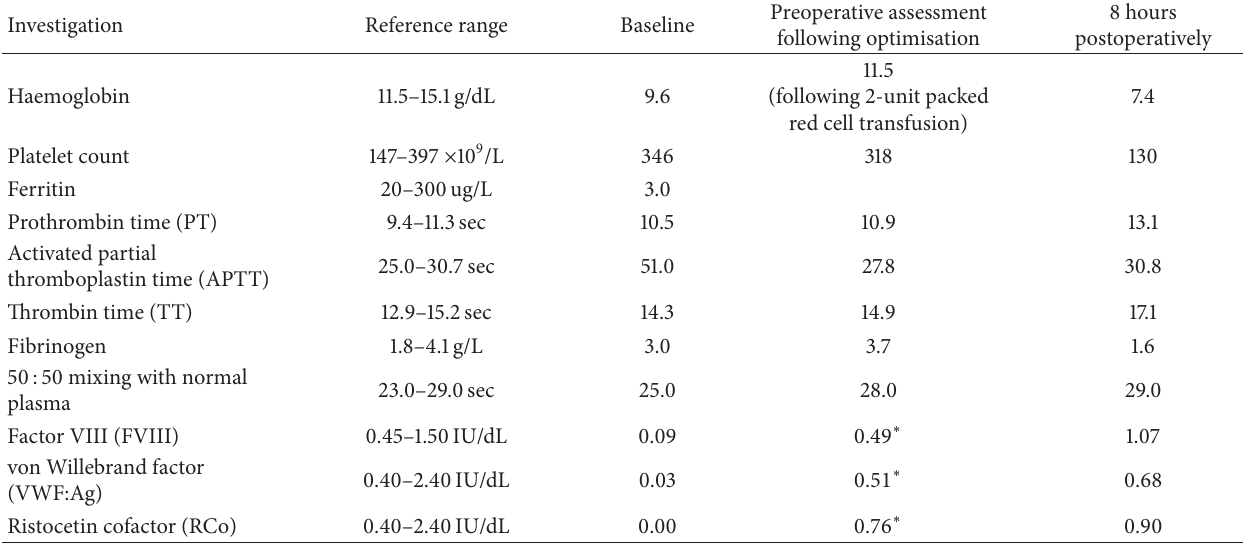
Table 4: Baseline and the immediate perioperative laboratory results.